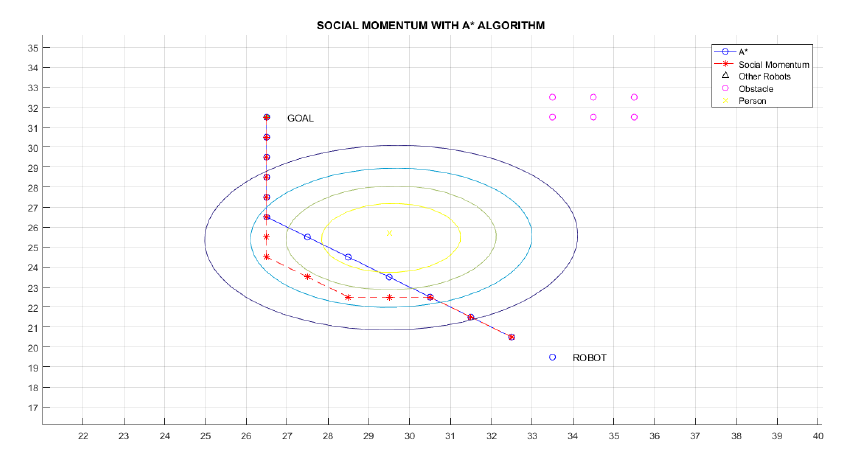
Figure 17. Path 1—Social Momentum Algorithm with